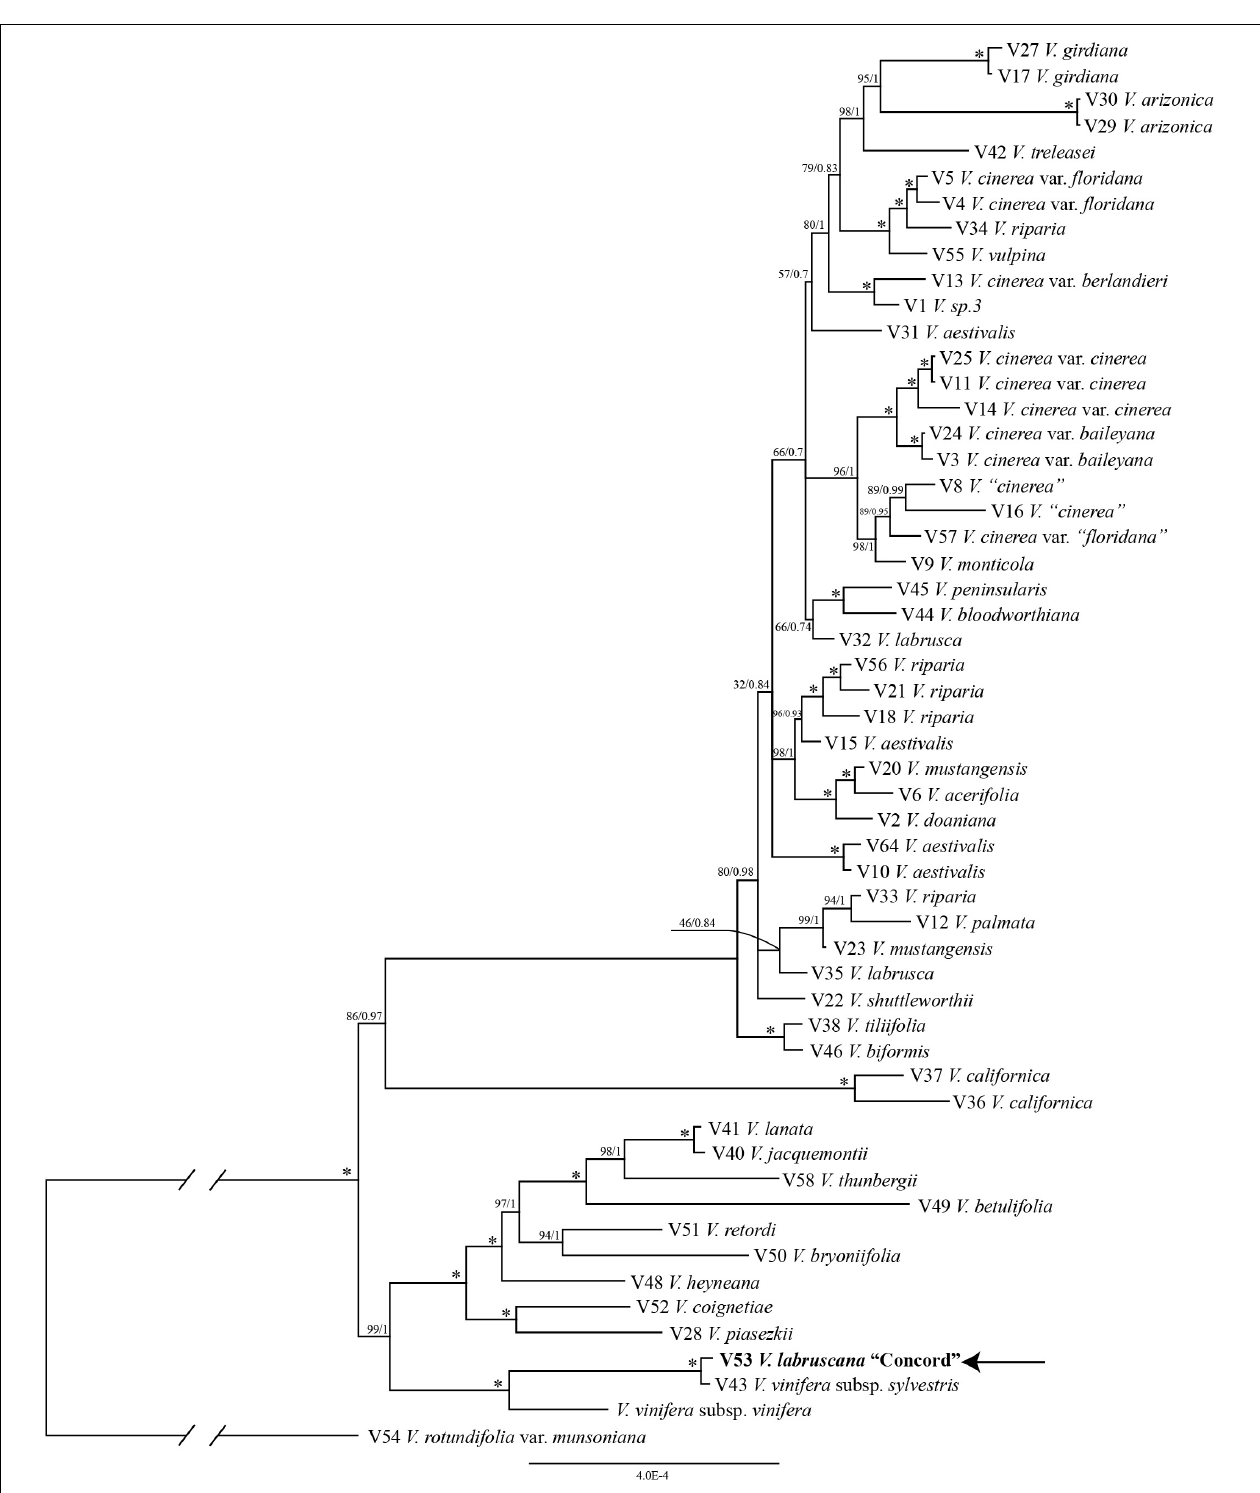
FIGURE 2 | Phylogenetic relationships of the Concord grape and its close allies in Vitis using complete chloroplast DNA genome sequences and Bayesian inference. Numbers associated with the branches are ML bootstrap support and Bayesian posterior probability values, and asterisks ( ∗ ) indicate bootstrap support/posterior probability of